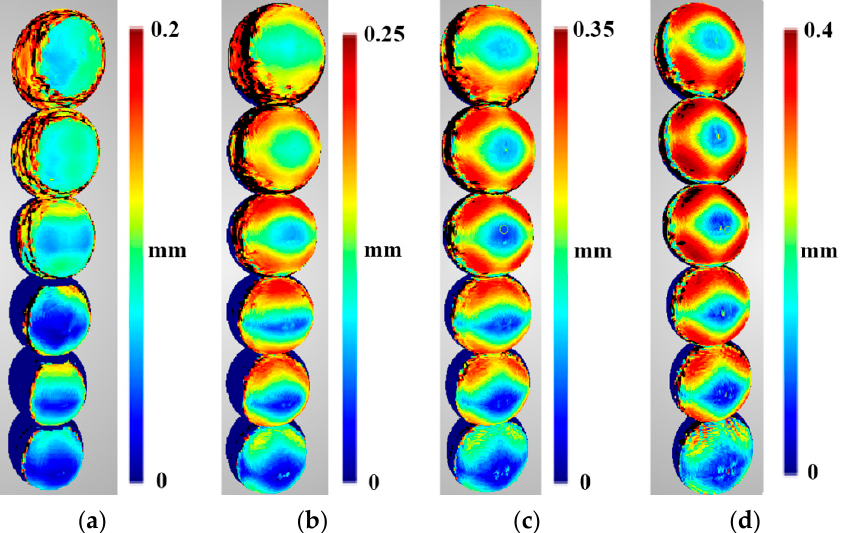
Figure 13. Evaluation of the accuracy of the reconstructed sphere at the following distances: ( a ) 2 m, ( b ) 3 m, ( c ) 4 m, and ( d ) 5m. Spheres in different rows were reconstructed from scenarios with different numbers of cameras. In order from bottom to top, these were as follows: two-, three-, four-, six-, nine-, and twelve-camera scenarios. Values higher than 0.2 mm for 2 m, 0.25 mm for 3 m, 0.35 mm for 4 m and 0.4 mm for 5 m, respectively, are marked in black.